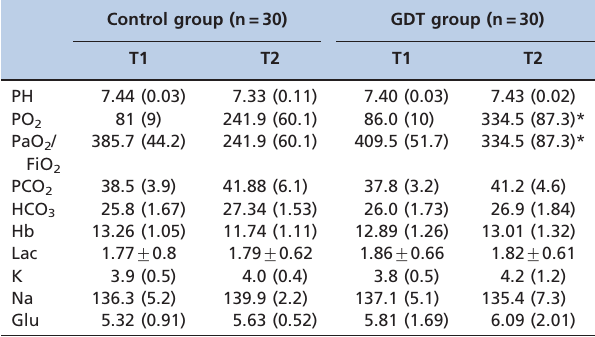
Table 2 - Arterial blood gas analysis.